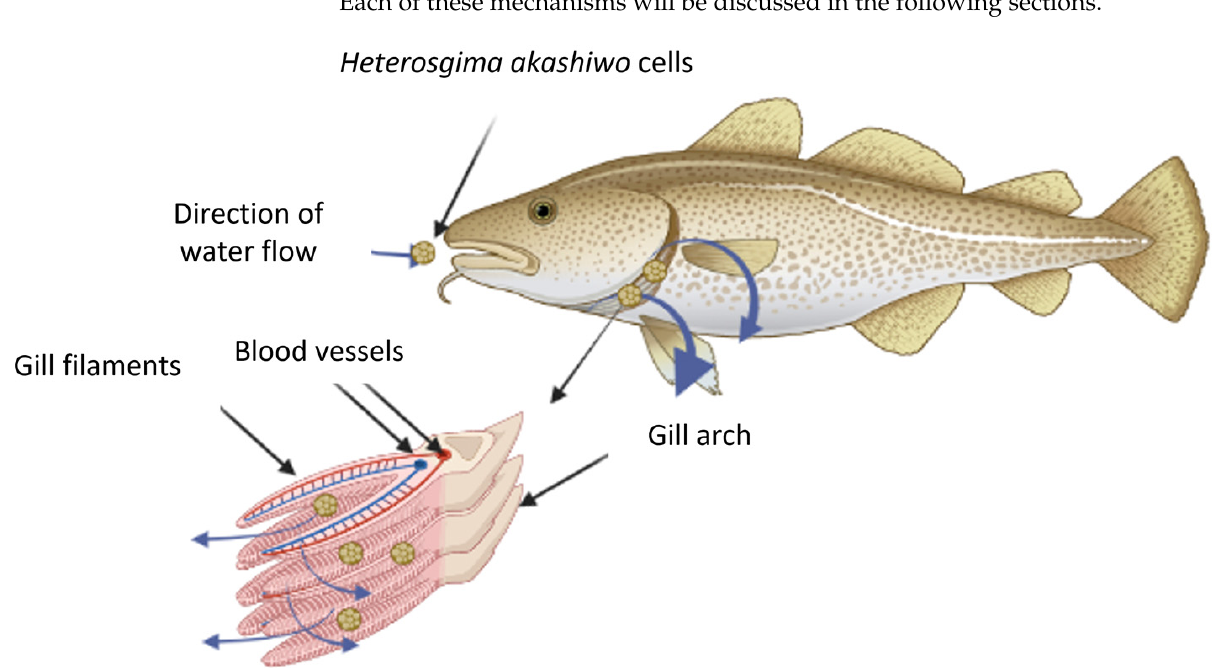
Figure 4. Framework for physiological activities associated with a fish kill by H.akashiwo . After at- tachment to the gill of the fish, algal cells embed into gill tissues using exoenzymes. The presence of